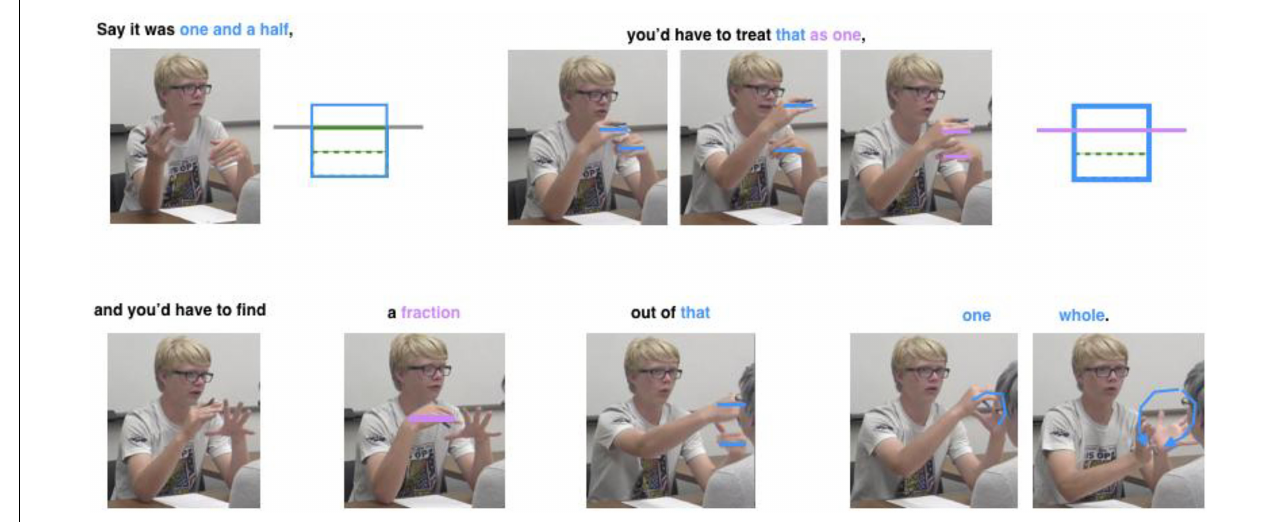
FIGURE 9 | Christian (pseudonym) using a mathematical model to explain his game tactics. Gestures have been enhanced in blue (the improper fraction quantity that represents a gold block) and purple (the unit whole that represents the hole containing the block) to connect Christian’s gestures more clearly with his spoken language; independent images of his referents have been